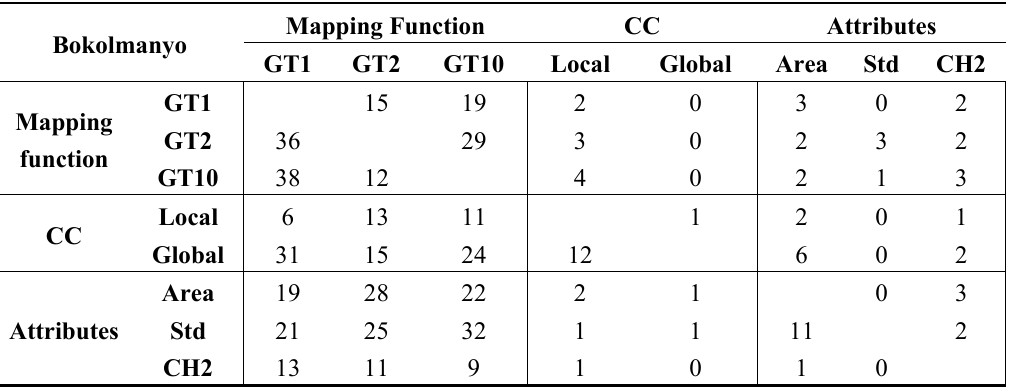
Table 4. Interdependency test of the method constituents for the Bokolmanyo problem. Note that all constituents affect one another. The mapping function affects all parameters most frequently.